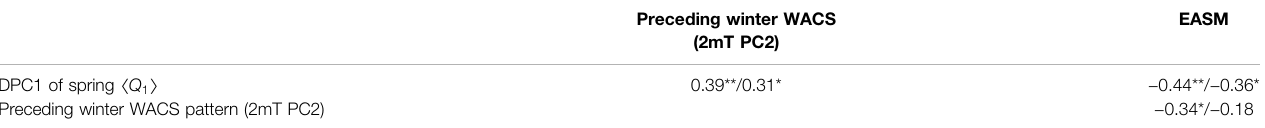
TABLE 2 | Correlation/partial correlation coef fi cients of the DPC1 with the previous winter WACS pattern and the EASM